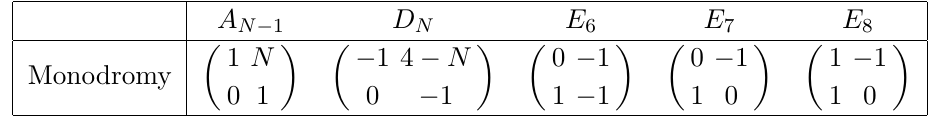
Table 1 . Monodromy of ADE singularities in elliptic (cid:12)brations. For the case D N we restrict N (cid:21) 4.